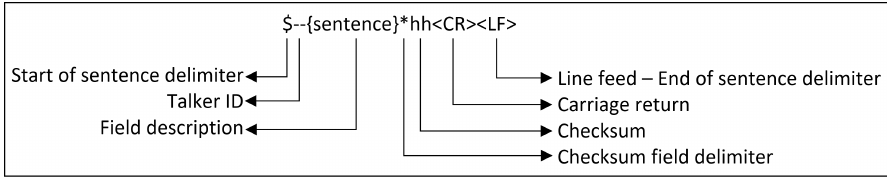
Figure 2. IEC 61162-1 (NMEA 0183) sentence